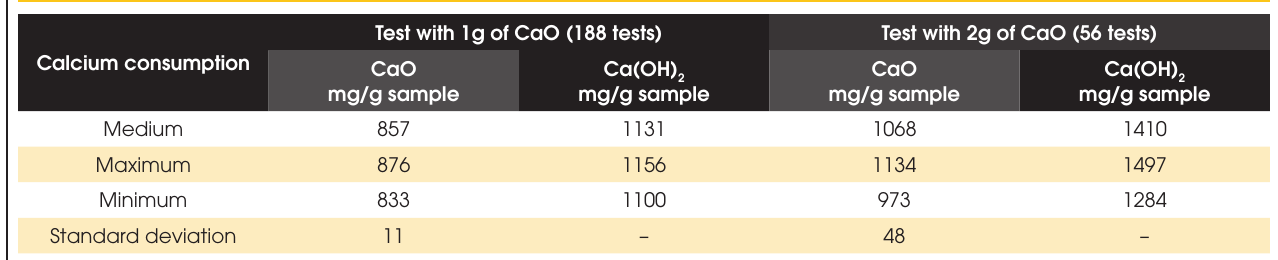
Table 1 – Calcium consumption of metakaolin as the reference material